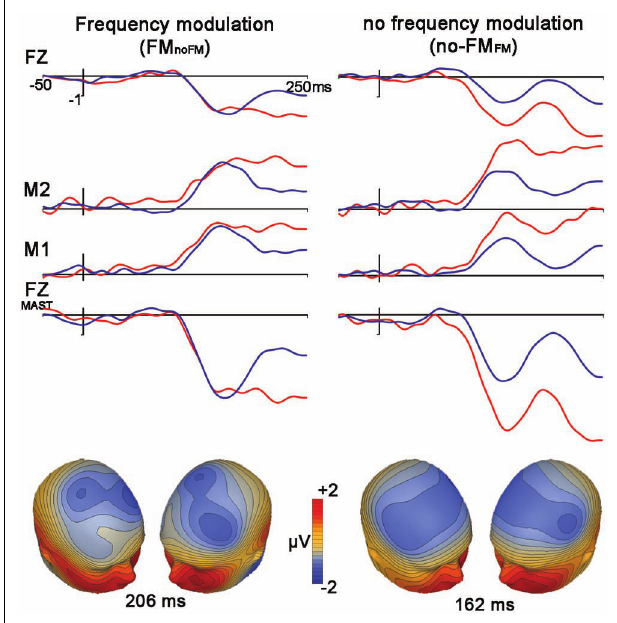
FIGURE 3 | Control condition. FM vs. no-FM. Figure legend follows that of Figure 2 .